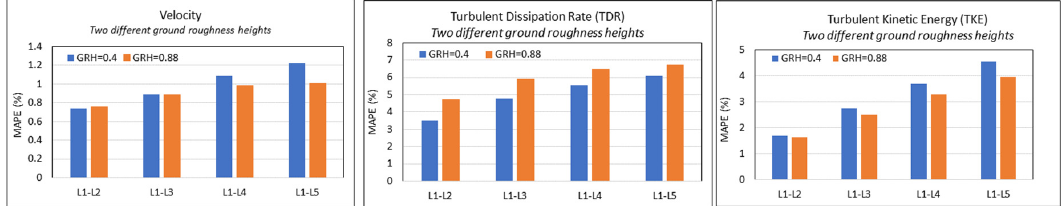
Figure 9. Case 2: CFX HHABL profile assessment for different ground roughness height Z s : effect of Z s on the M ean A bsolute P ercentage E rrors/differences ( MAPE ) at each location (relative to the inlet values) for each parameter using the different software.